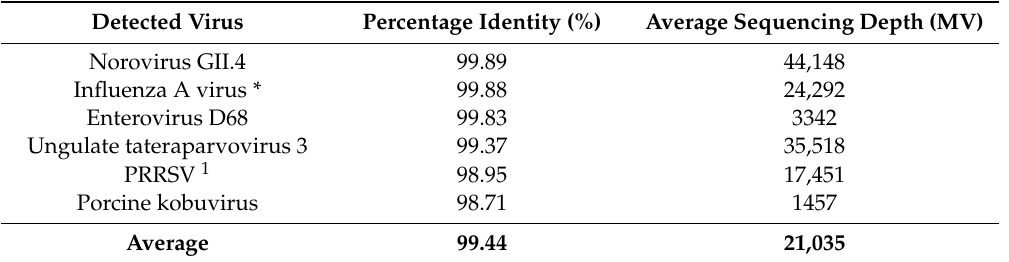
Table 4. Similarity of ONT consensus sequences compared to Illumina consensus